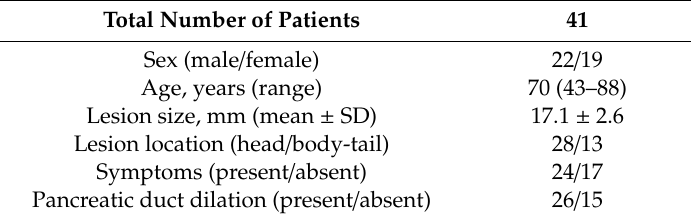
Table 1. Characteristics of patients with pancreatic cancer measuring 11–20 mm.